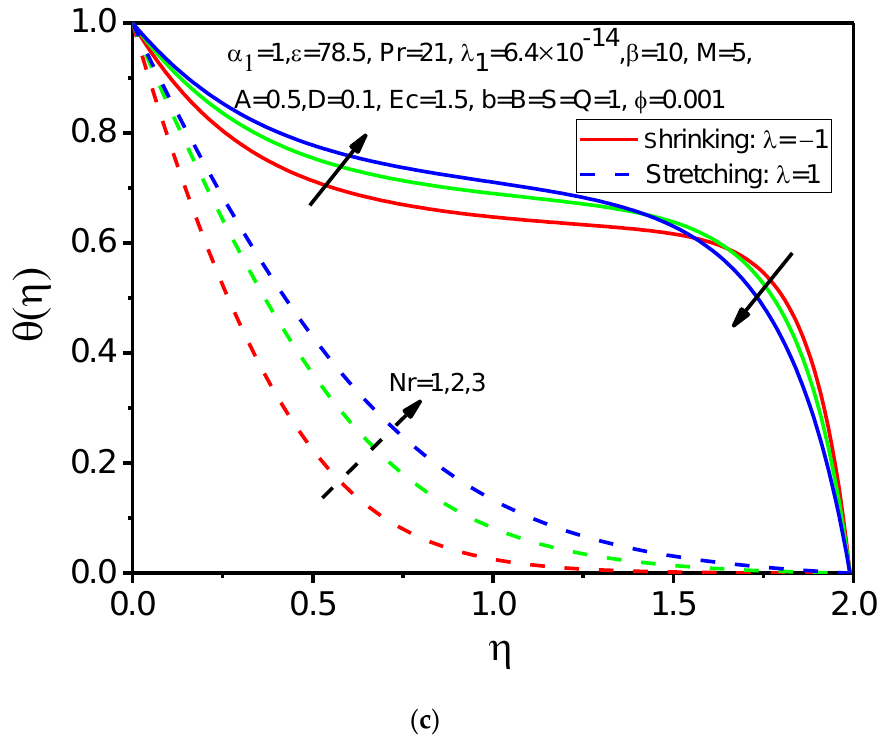
Figure 11. Variation of Nr on ( a ) Velocity profile, ( b ) Pressure profile, ( c ) Temperature profile.